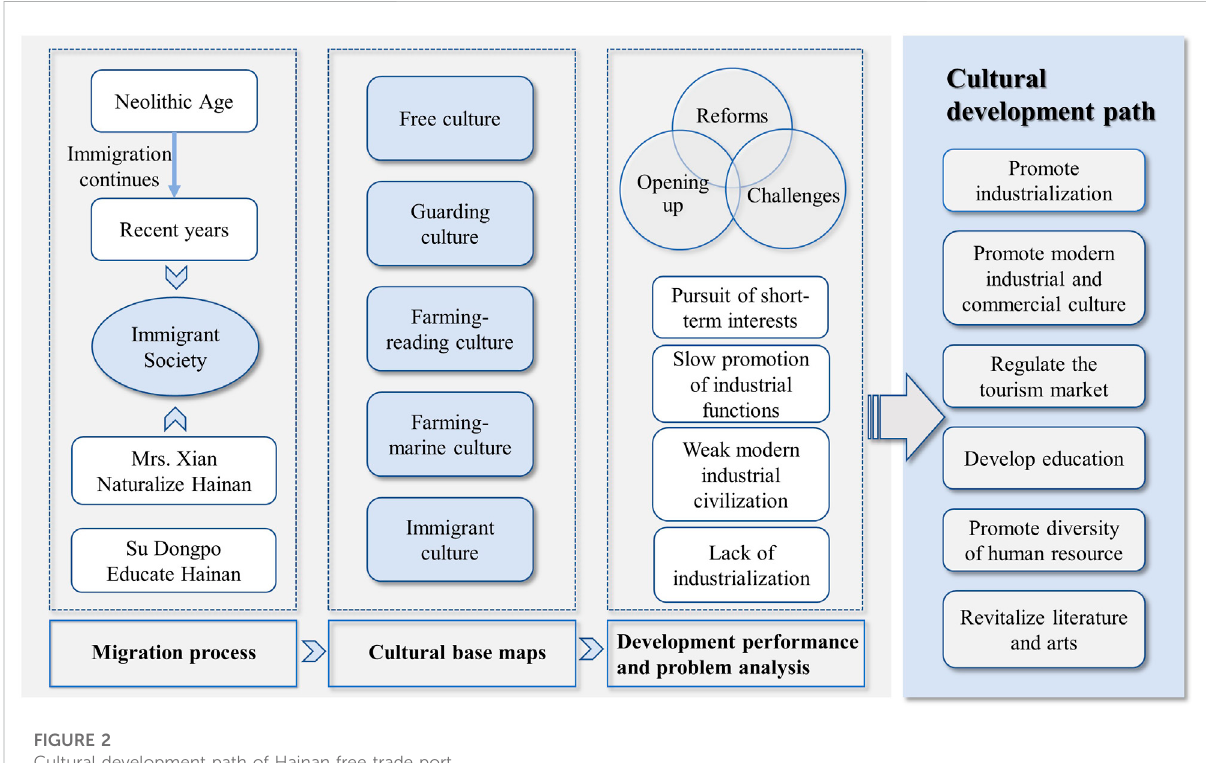
FIGURE 2 Cultural development path of Hainan free trade